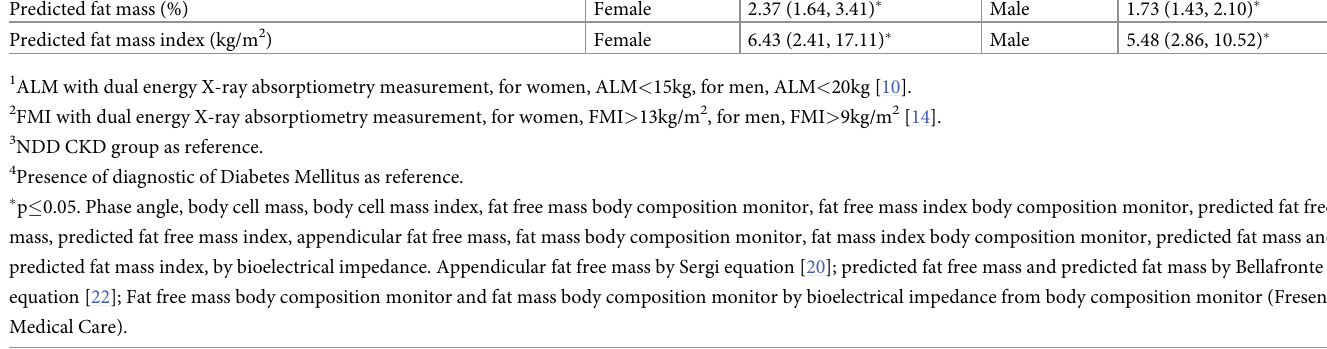
For all conditions, BIS data had a better performance than anthropometric variables. Data about sensitivity and specificity of the best bed-side measurements for low muscle mass (AFFM and CC), obesity (FMIBCM and WC/H), sarcopenia (AFFM+HGS and CC +HGS) and sarcopenic obesity (FMIBCM+AFFM) in each CKD subgroups are presented in S4 Table.